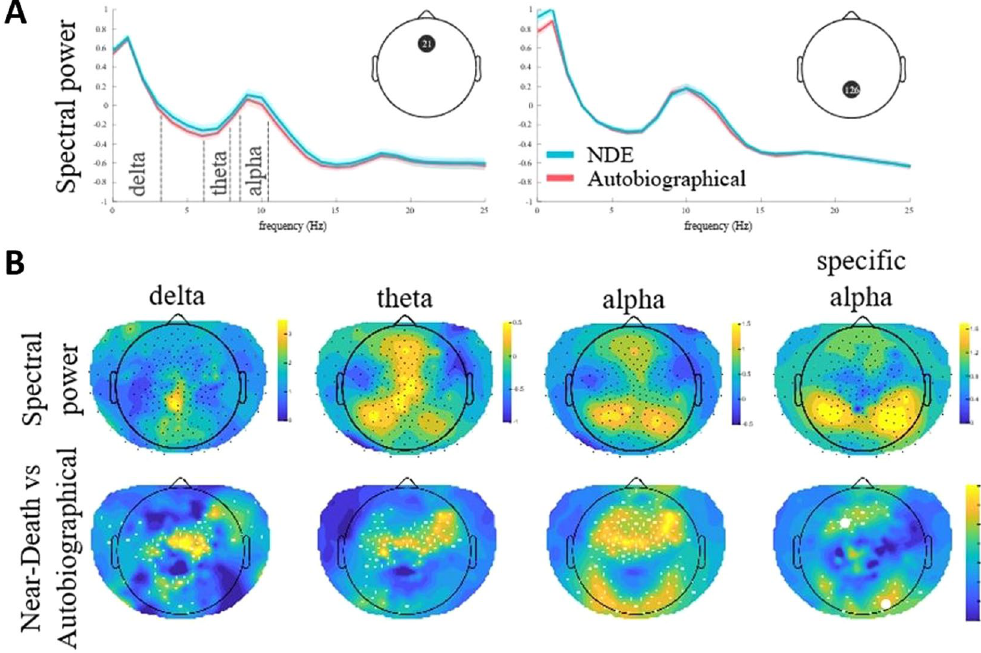
Figure 2. Effects of near-death experience (NDE) condition on spectral power (irrespective of whether this was in a hypnosis or normal consciousness experimental session). ( A ) The figure shows the power at a central frontal channel (left) and a central posterior channel (right), across all frequencies between 0 and 25 Hz. There are clear peaks at both channels at the low, delta frequencies, and around the alpha frequency which are then further examined. ( B ) The top panel shows the spectral power across all channels at selected frequency bands: delta (0.5–3.5 Hz), theta (7–8 Hz) and alpha (10–11 Hz) and “specific” alpha (alpha - theta band). The bottom panel shows the contrast between the EEG activity when participants described their NDE versus when they experienced another autobiographical event as T-values (i.e., mean difference normalized by variance). Regions in yellow indicate increased spectral power in the NDE condition (irrespective of whether this was in a hypnosis or normal consciousness experimental session). Significantly different channels are marked by white spots.